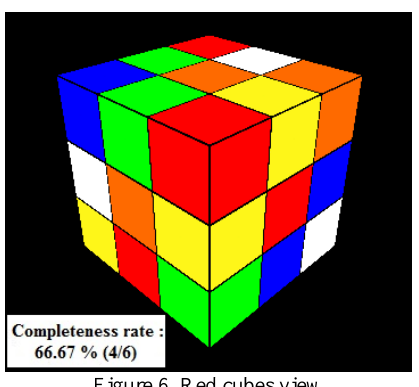
Figure 6. Red cubes